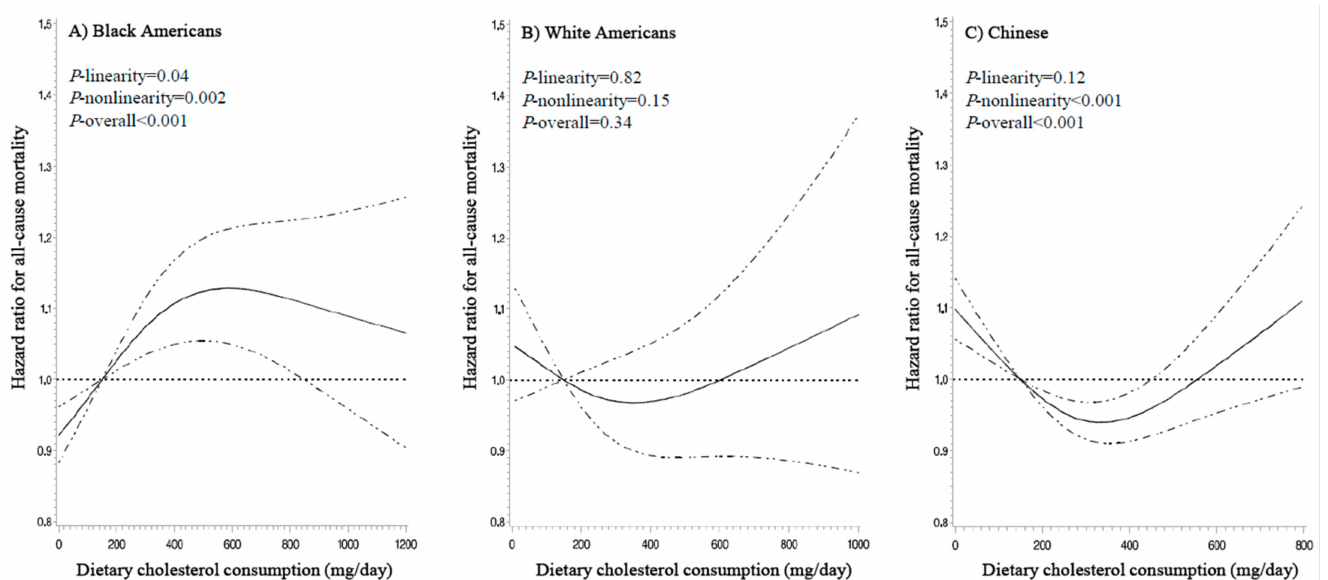
Figure 1. Dose-response relationships of dietary cholesterol intake with all-cause mortality. HRs (solid line) and 95% CIs (dashed line) were adjusted for age, sex, education, annual income, marital status, total energy intake, smoking status, smoking pack-years, alcohol consumption, physical activity level, body mass index, healthy eating index, history of diabetes, hypertension, dyslipidemia, coronary heart disease, and stroke, and hormone replacement therapy (for women only). Intake of refined carbohydrate was further adjusted for in the Chinese population. To minimize the potential effects of extreme values, participants with the top 1% of cholesterol intake were excluded from the analysis; 150 mg/day was set as the reference, and three knot positions were fitted at the 5th, 50th, and 95th percentiles. P -nonlinearity values for all-cause mortality were 0.002 in Blacks, 0.15 in Whites, and <0.001 in Chinese, respectively. Abbreviations: CI, confidence interval; HR, hazard